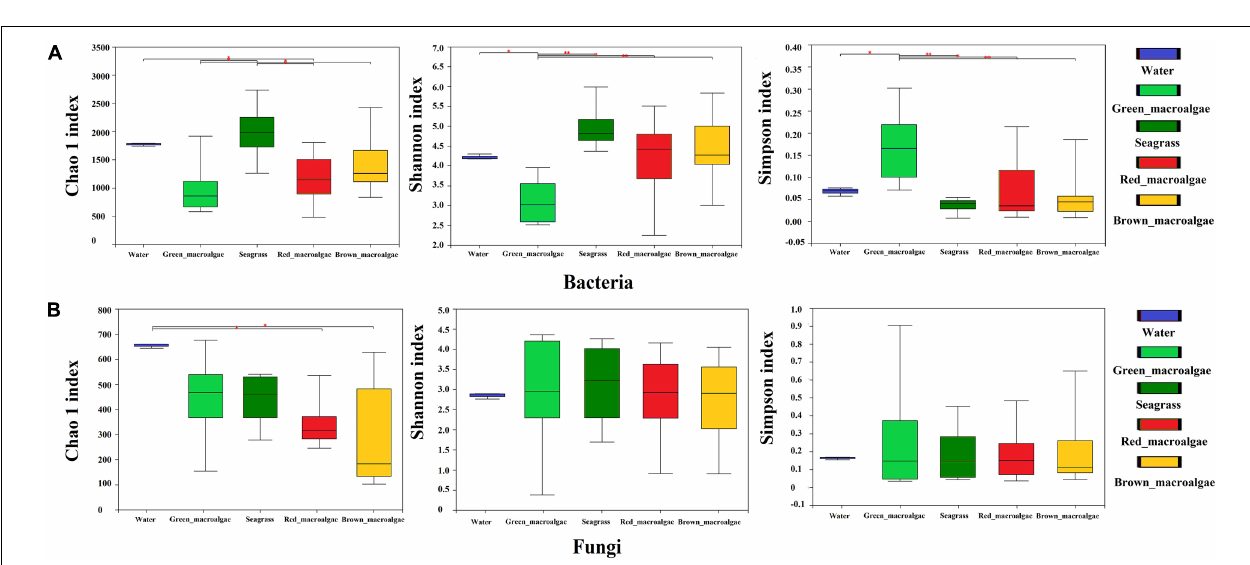
FIGURE 2 | Venn diagrams showing the unique and shared operational taxonomic units (OTUs) between the seawater, green macroalgae, red macroalgae, brown macroalgae, and seagrass. (A) Venn diagrams of bacterial OTUs. (B) Venn diagrams of fungal OTUs.